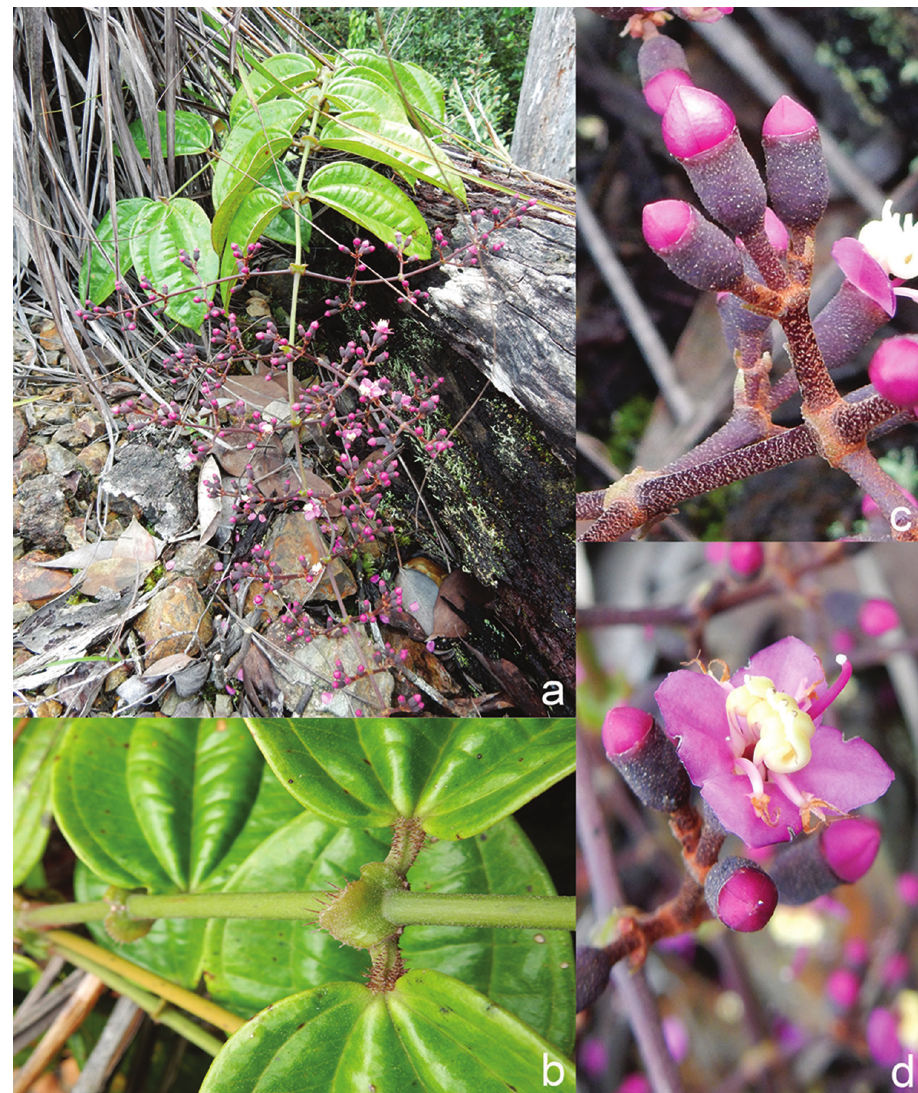
Figure 15. Dissochaeta glabra var. kinabaluensis . a habit b branchlet c hypanthium d flower. Photo- graphs by D. Penneys; voucher: Penneys 2542